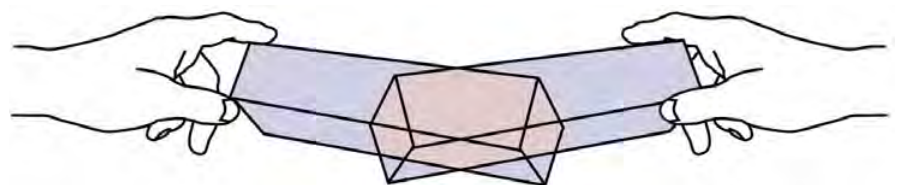
Figure 8. Kitoparts enable users to explore shape embedding where they could not with physical